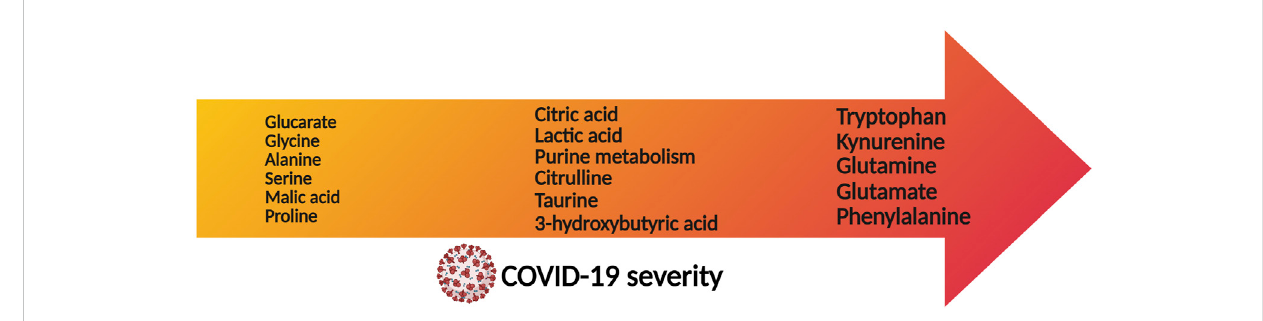
FIGURE 3 Metabolites that are associated with severity prognosis of COVID-19, sorted according to the disease severity (arrow